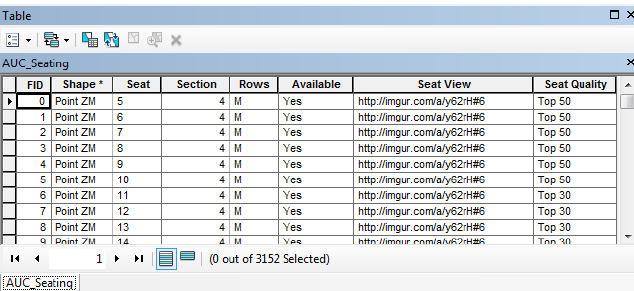
Figure 12: Picture database design